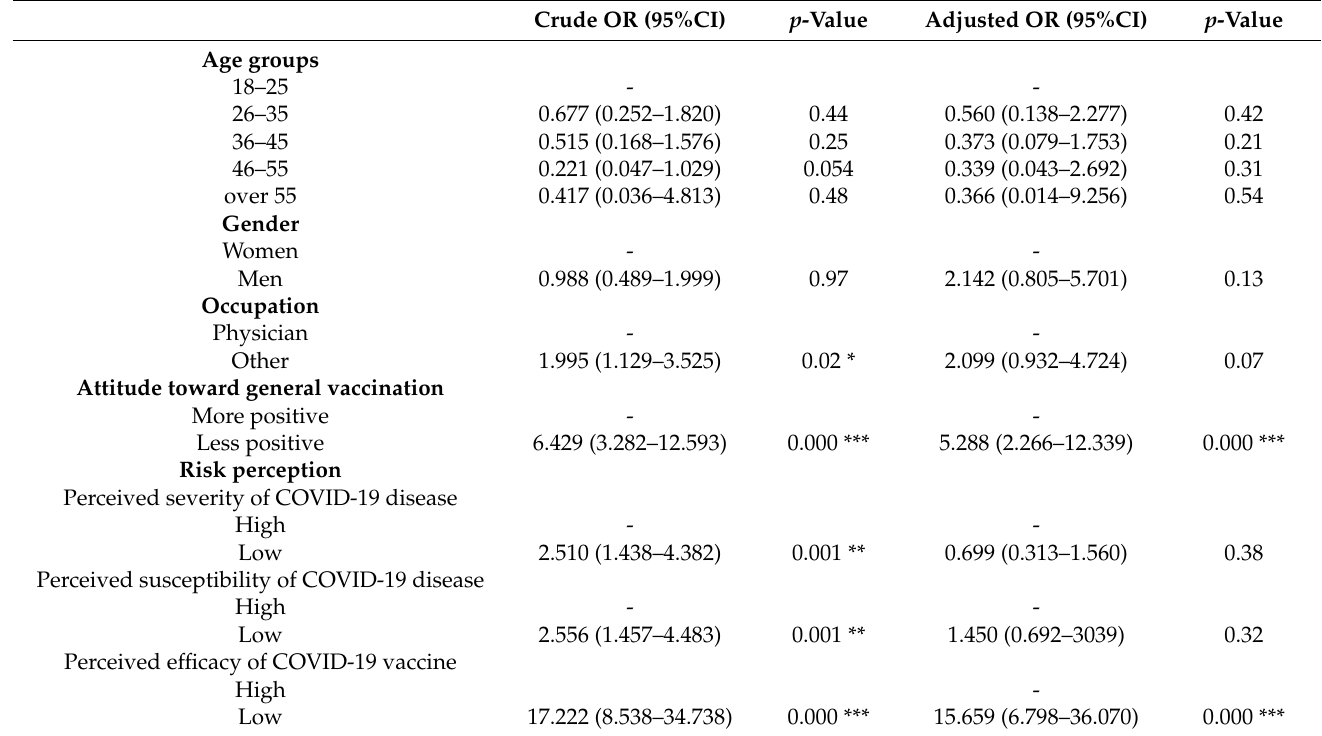
Table 4. Associations between demographic characteristics, attitude toward general vaccination, risk perceptions, and COVID-19 vaccination